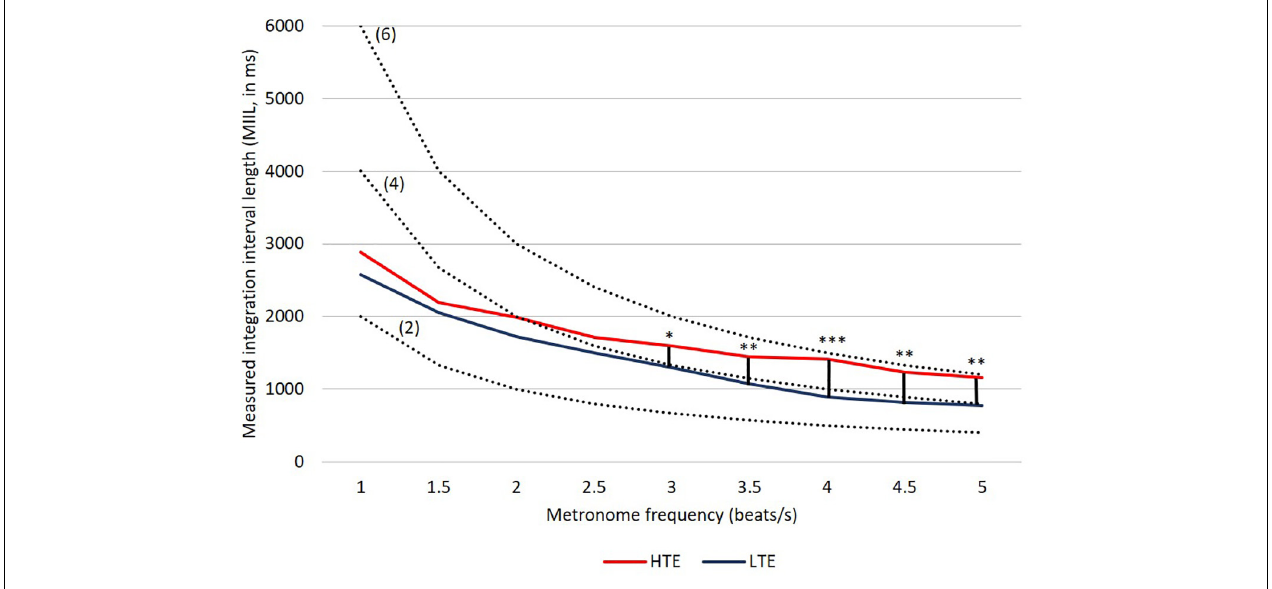
FIGURE 4 | MIILs for various metronome tempos in HTE and LTE groups. Gray lines reflect two hypothetical integration strategies: (A) integration in a constant time limited up to e.g., 3,000, 2,500, or 2,000 ms (solid horizontal lines) and (B) integration by mental counting ignoring the constant time (e.g., up to 2, 4 or 6 beats, dashed lines). Significant differences between groups are marked with asterisks: ∗ p < 0.05; ∗∗ p < 0.01; ∗∗∗ p < 0.001. For more details see Table 2 and text